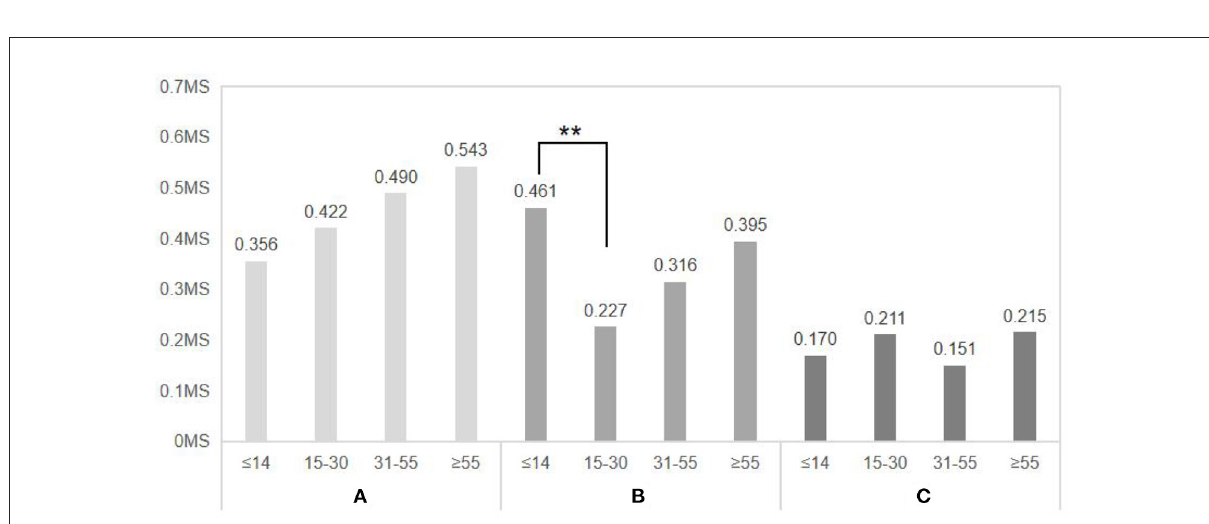
FIGURE12 Comparison of the difference in skin electricity after entering three virtual spaces for subjects of different ages. N = 48; mean ± SD; ** P < 0.01; verified by ANOVA.